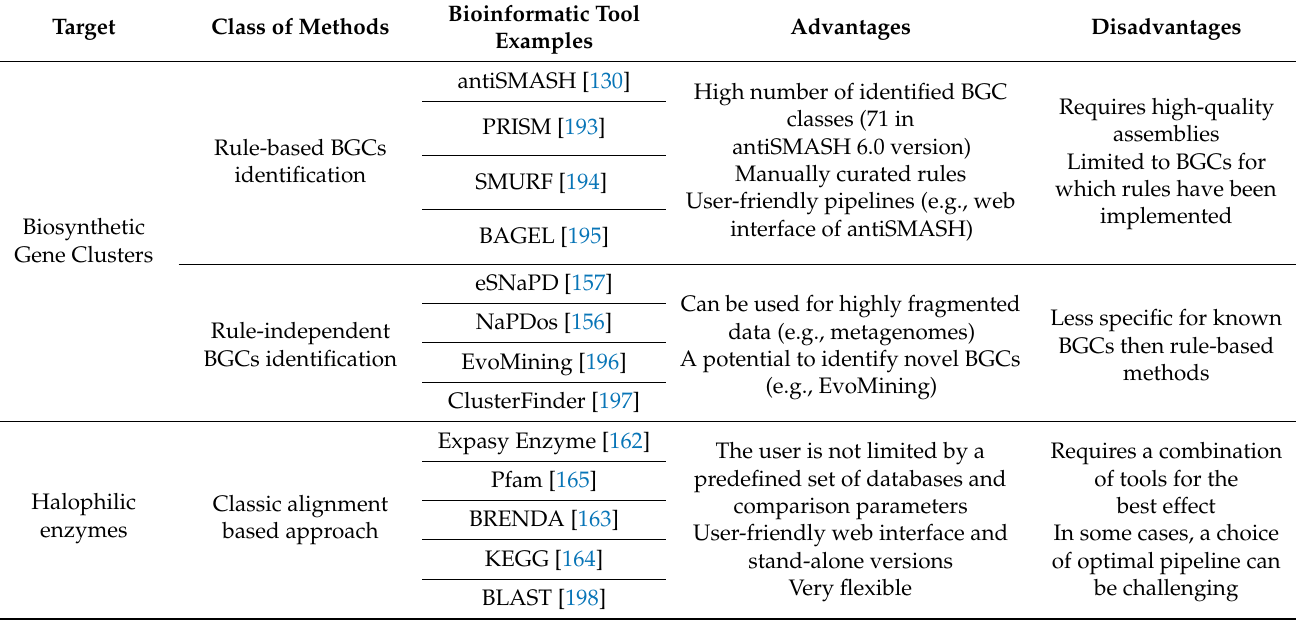
Table 1. Strengths and weaknesses of methods used in the in silico identification of